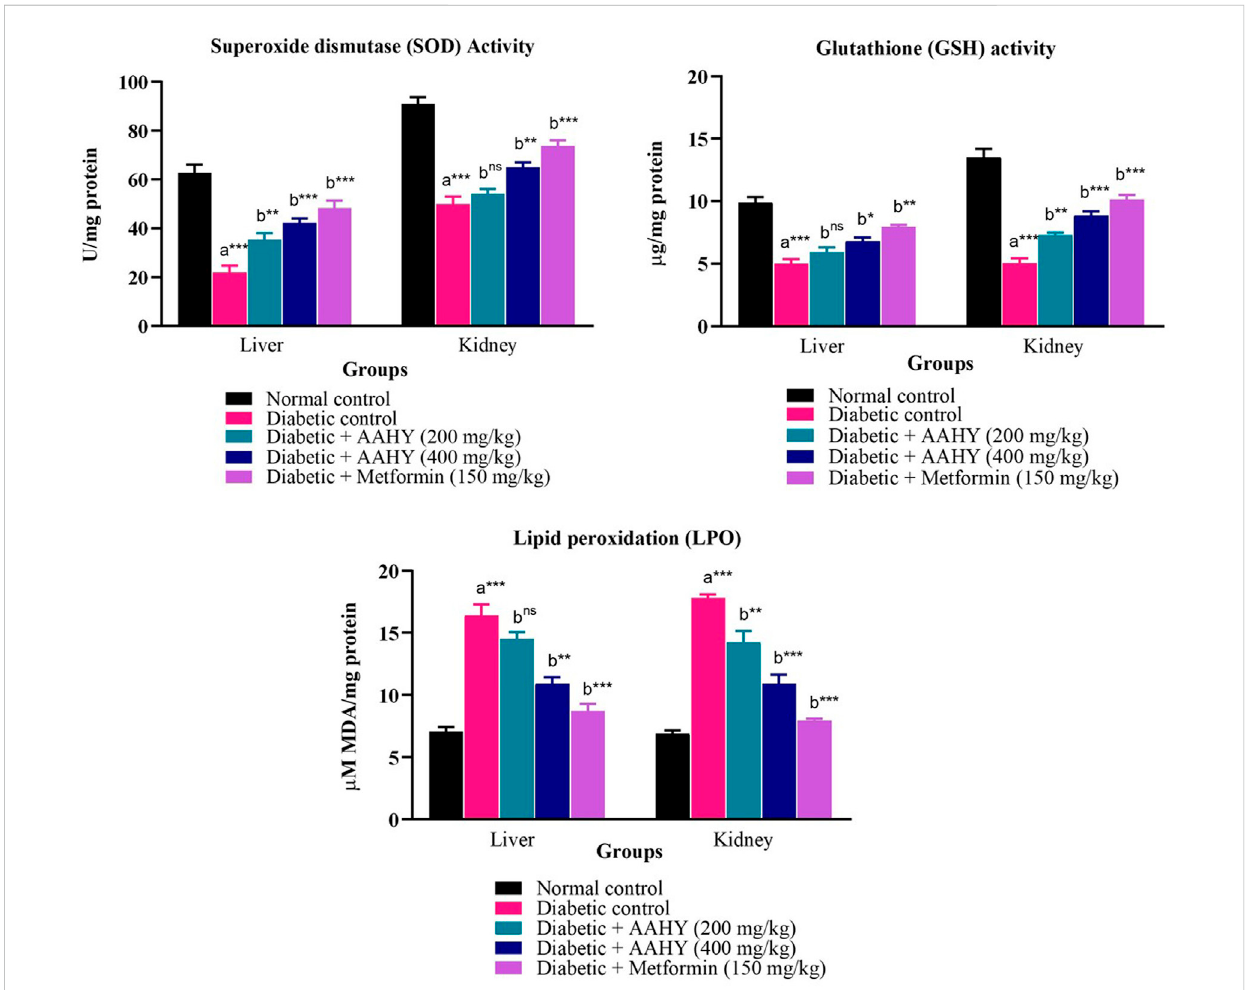
FIGURE 7 Effect of the AAHY extract on liver and kidney tissue antioxidant parameters. The error bar denotes mean ± SEM, and n = 6 for each group. a representsthediabeticcontrolgroupversusthenormalcontrolgroup,andbrepresentsthediabeticcontrolgroupversustreatedgroups.* p < 0.05,** p < 0.01, and *** p < 0.001. SEM: standard error of